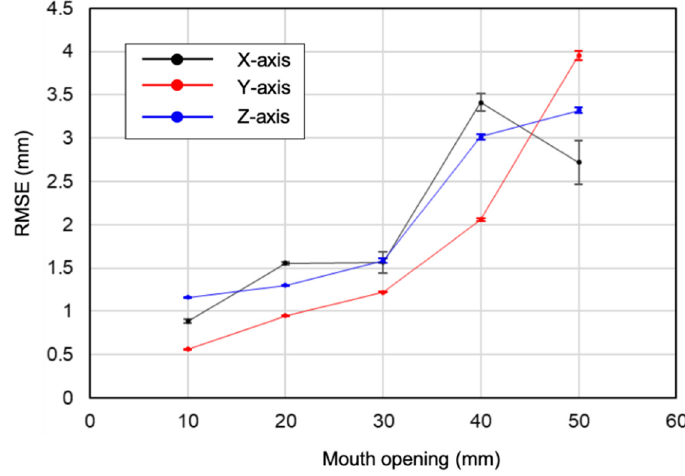
Figure 13. Root mean squared error (RMSE) calculated from the data of 10 trajectories of mouth opening.